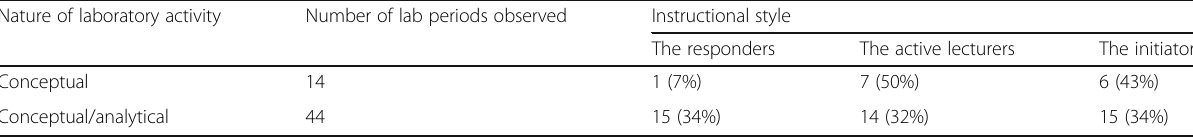
Table 6 Relationship between nature of laboratory activity and chemistry GTAs ’ instructional style Nature of laboratory activity Number of lab periods